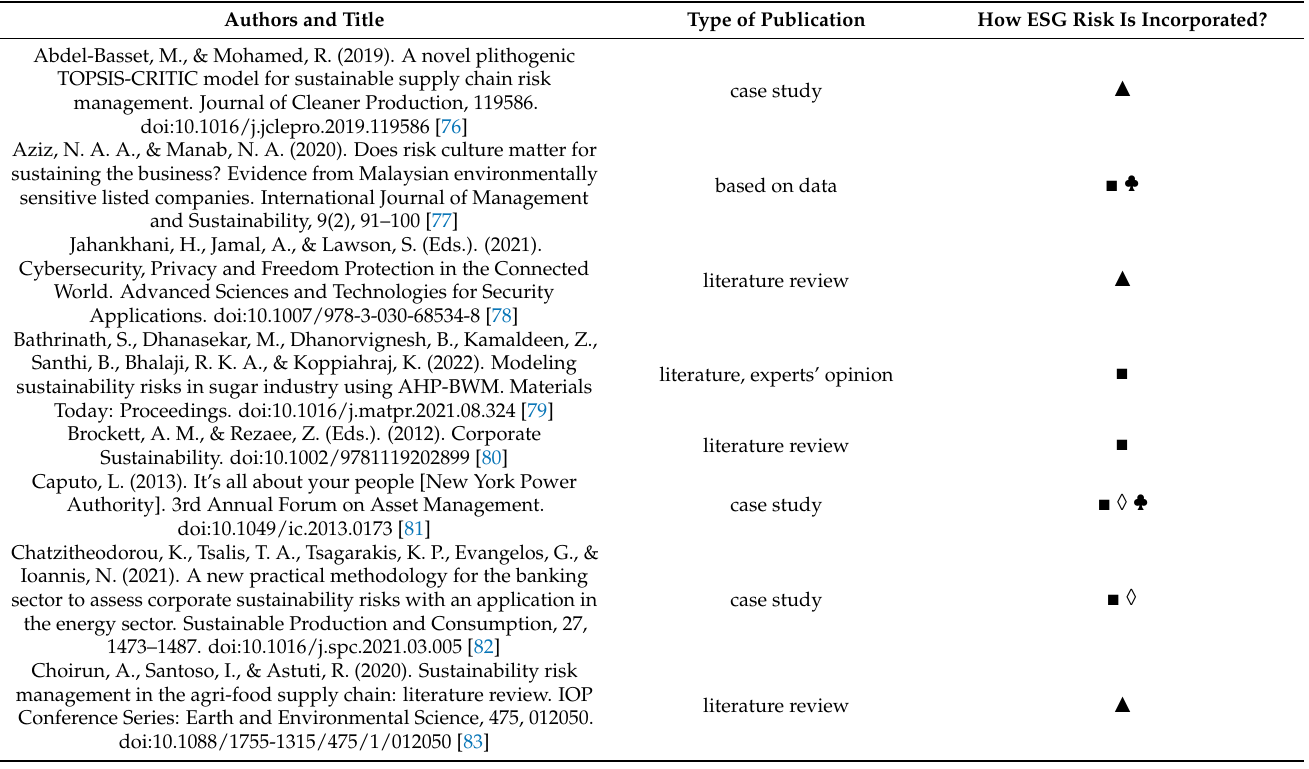
Table 17. List of publications with methods of incorporating ESG risk into business models.